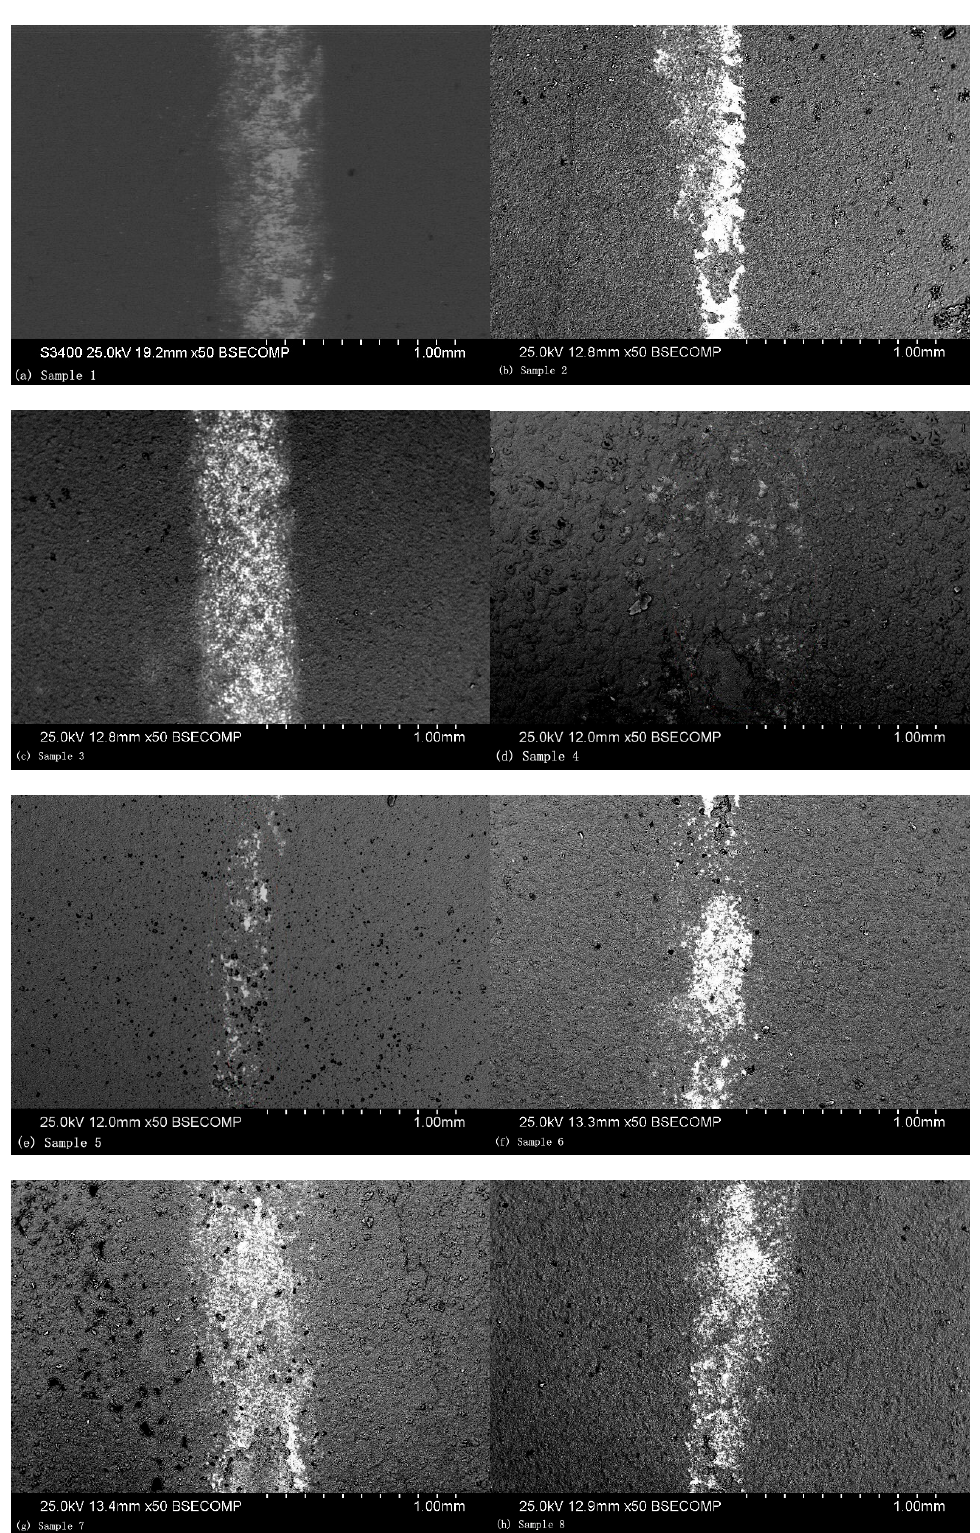
Figure 6. SEM observation of the grinding crack morphology: ( a ) Sample 1, ( b ) Sample 2, ( c ) Sample 3, ( d ) Sample 4, ( e ) Sample 5, ( f ) Sample 6, ( g ) Sample 7, and ( h ) Sample 8.